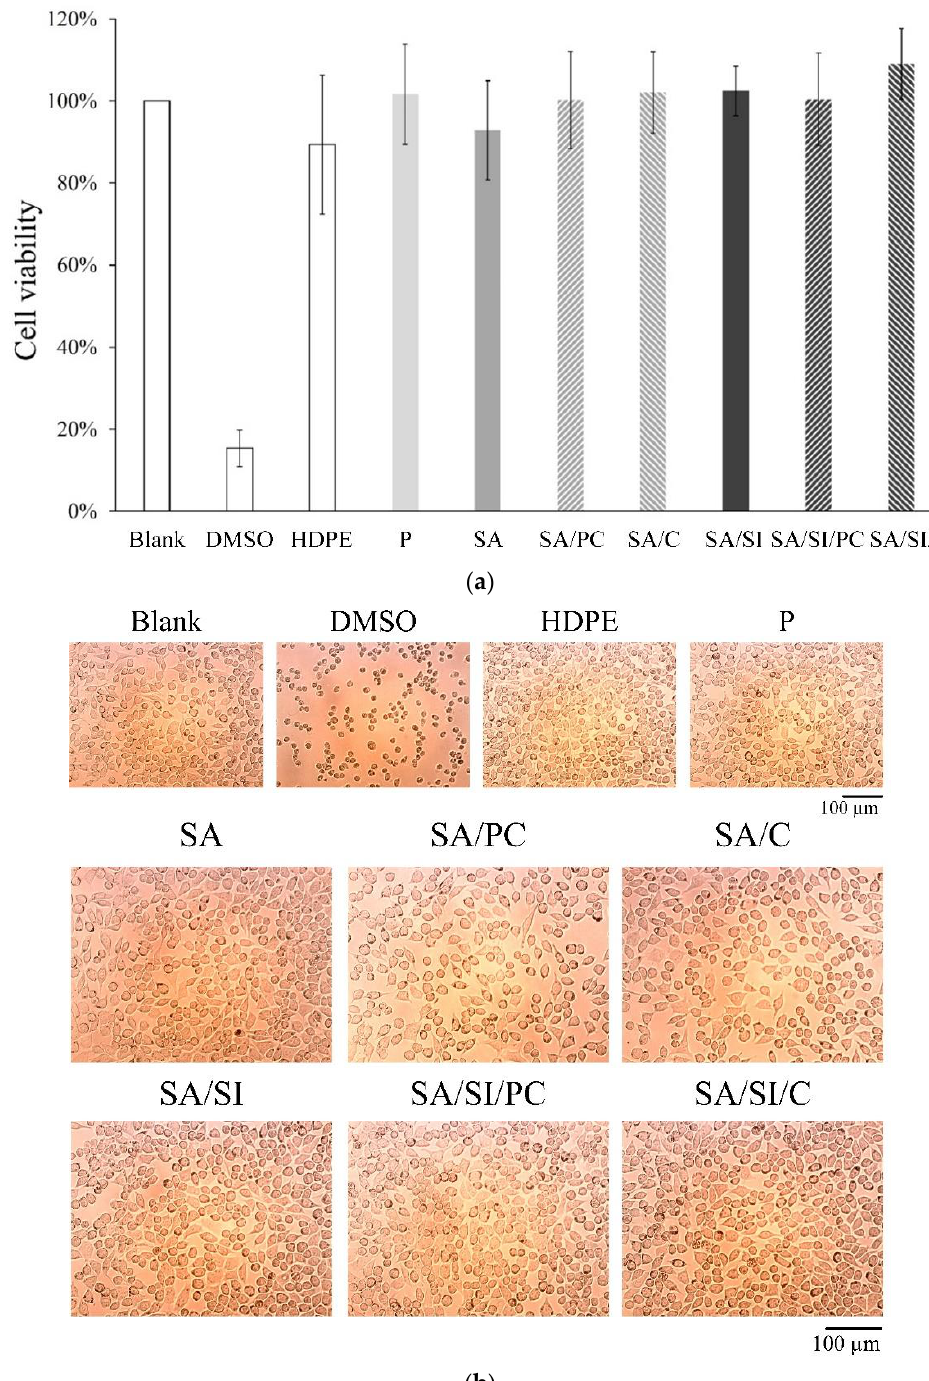
Figure 7. Surface-modified PEEK cytotoxicity test: ( a ) cell viability indicates the proportion of live and healthy cells within a population under cell viability assay analysis ( n = 6) and ( b ) optical images of cell morphological observation.